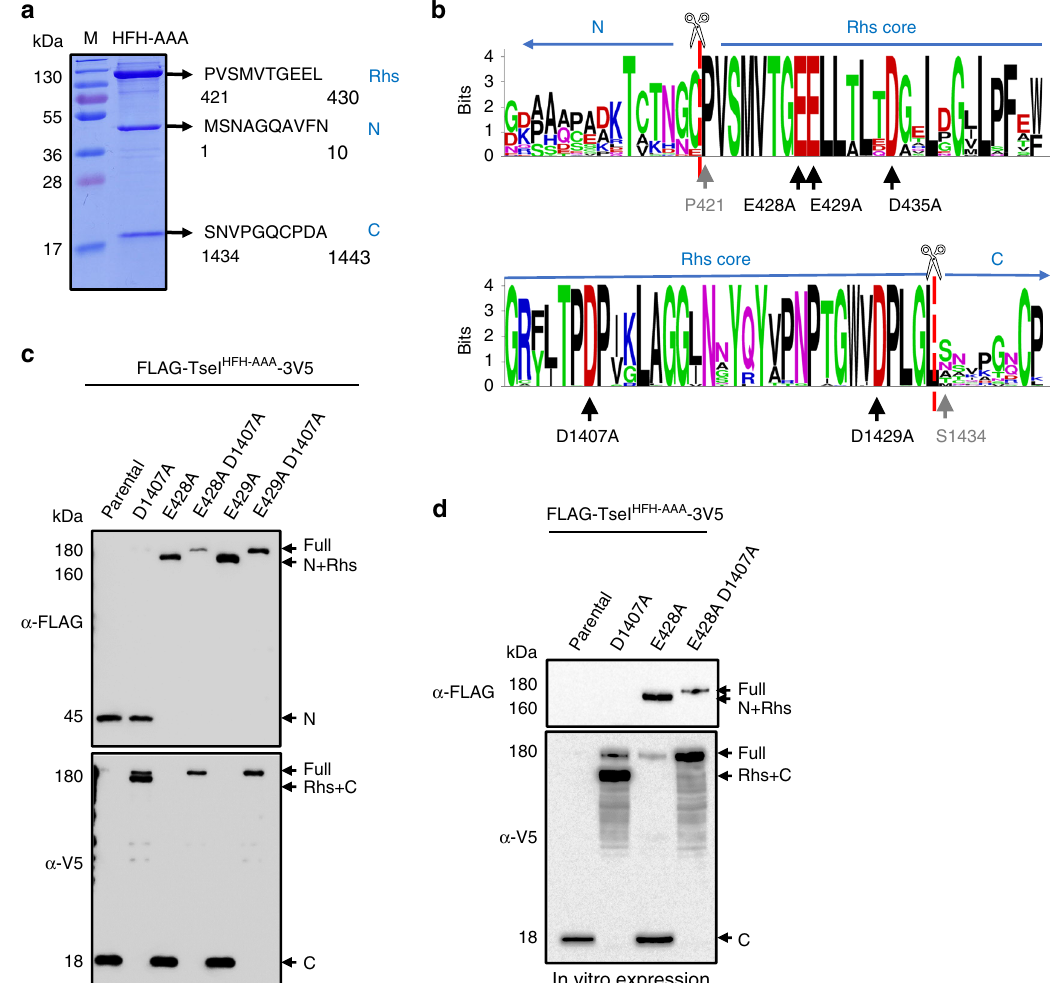
Fig. 2 Characterization of TseI cleavage and key residues. a Cleavage sites determined by N-terminal sequencing. Each band was excised for N-terminal Edman sequencing as well as LC-MS/MS identi fi cation (see also Supplementary Fig. 3A). b Weblogo depicting conserved residues of Rhs N-/C-terminal sequences deriving from sequence alignment of 48 representative Rhs homologs. Sequences are provided in Supplementary Data 1. Black arrows indicate the predicted key activity residues that are mutated in this study while gray arrows indicate the fi rst residue of Rhs and VIRC post cleavage, respectively. c Western blotting analysis of TseI and its cleavage-defective mutants. All constructs were cloned to pETDUET1 vectors with an N-terminal FLAG tag and a C-terminal 3V5 tag. Proteins were induced in E. coli with 0.01 mM IPTG. The nontoxic HFH-AAA TseI mutant is used as the parental construct. The same pETDUET1 constructs were also used for in vitro expression shown in d . In vitro expression was performed with a PURExpress ® In Vitro Protein Synthesis Kit following the manufacturer's instruction. Synthesized proteins were subject to SDS-PAGE analysis, followed by western blot analysis with anti-FLAG and anti-V5 antisera. Source data are provided as a Source Data fi le. Data in a , c , d are representative of at least two